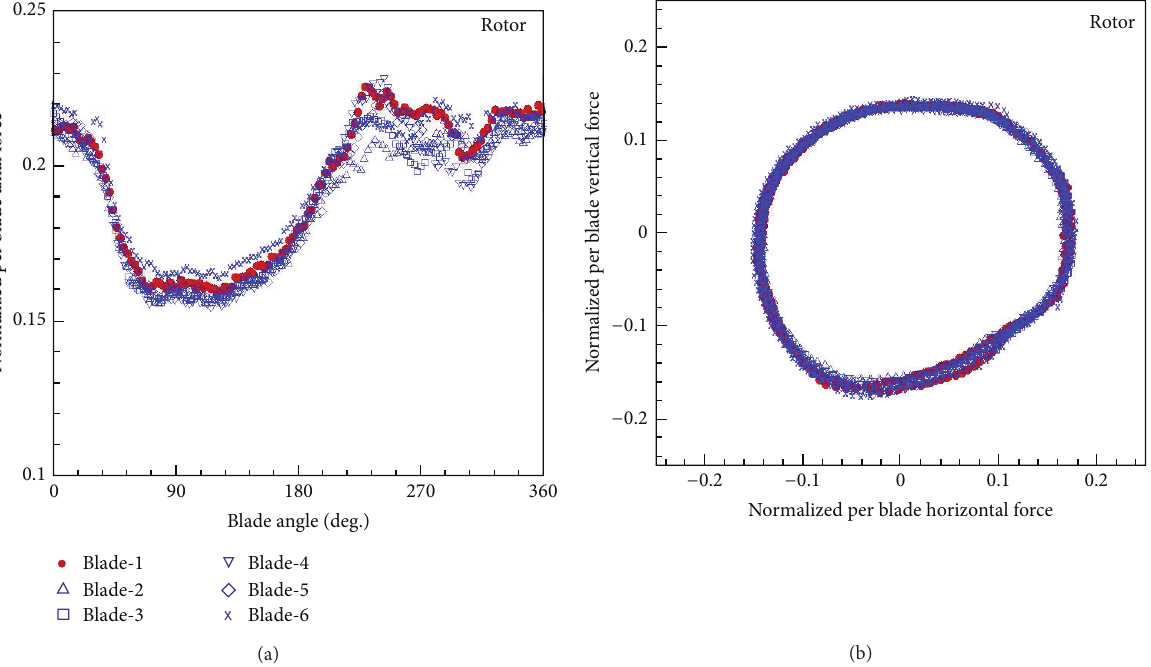
Figure 16: Normalized unsteady cavitating axial forces for all six rotor blades along one revolution in rotating blade-fixed coordinates (a), and per blade horizontal and vertical side forces for all six rotor blades in ship-fixed coordinates (b).